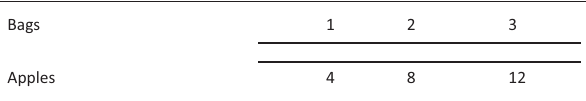
FIGURE 3: Double number line for 1:4